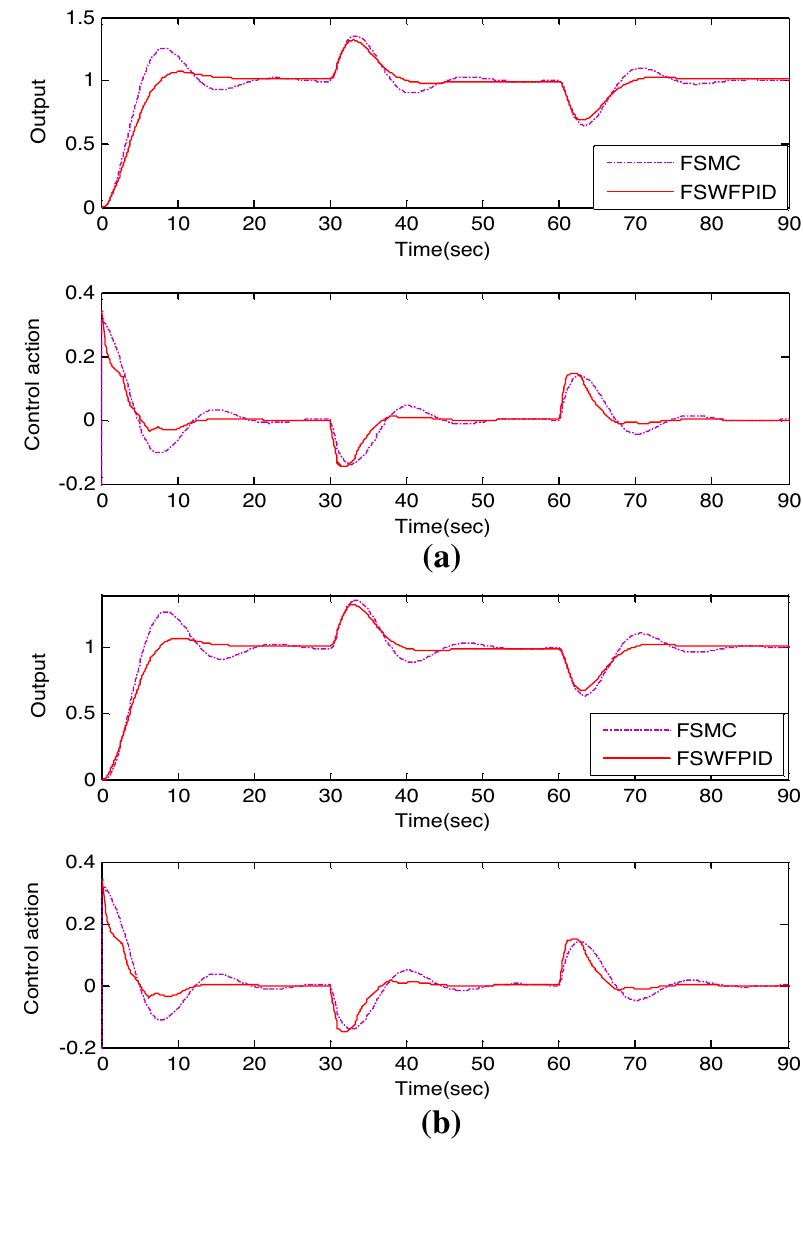
Fig. 23 Comparison among responses and control actions for Model V with FSMC using 25 rules during set point response and with load varia- tion for a L = 0.2 s, b L = 0.3